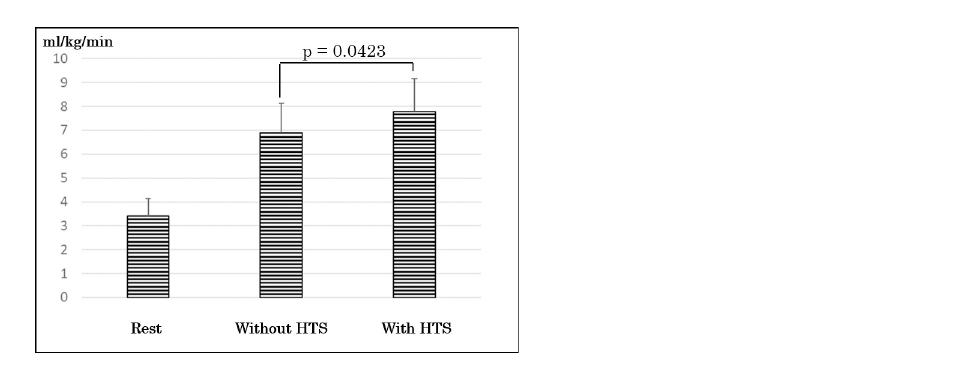
Fig 4. Comparing of changes of carbon dioxide production. HTS, hybrid training system.